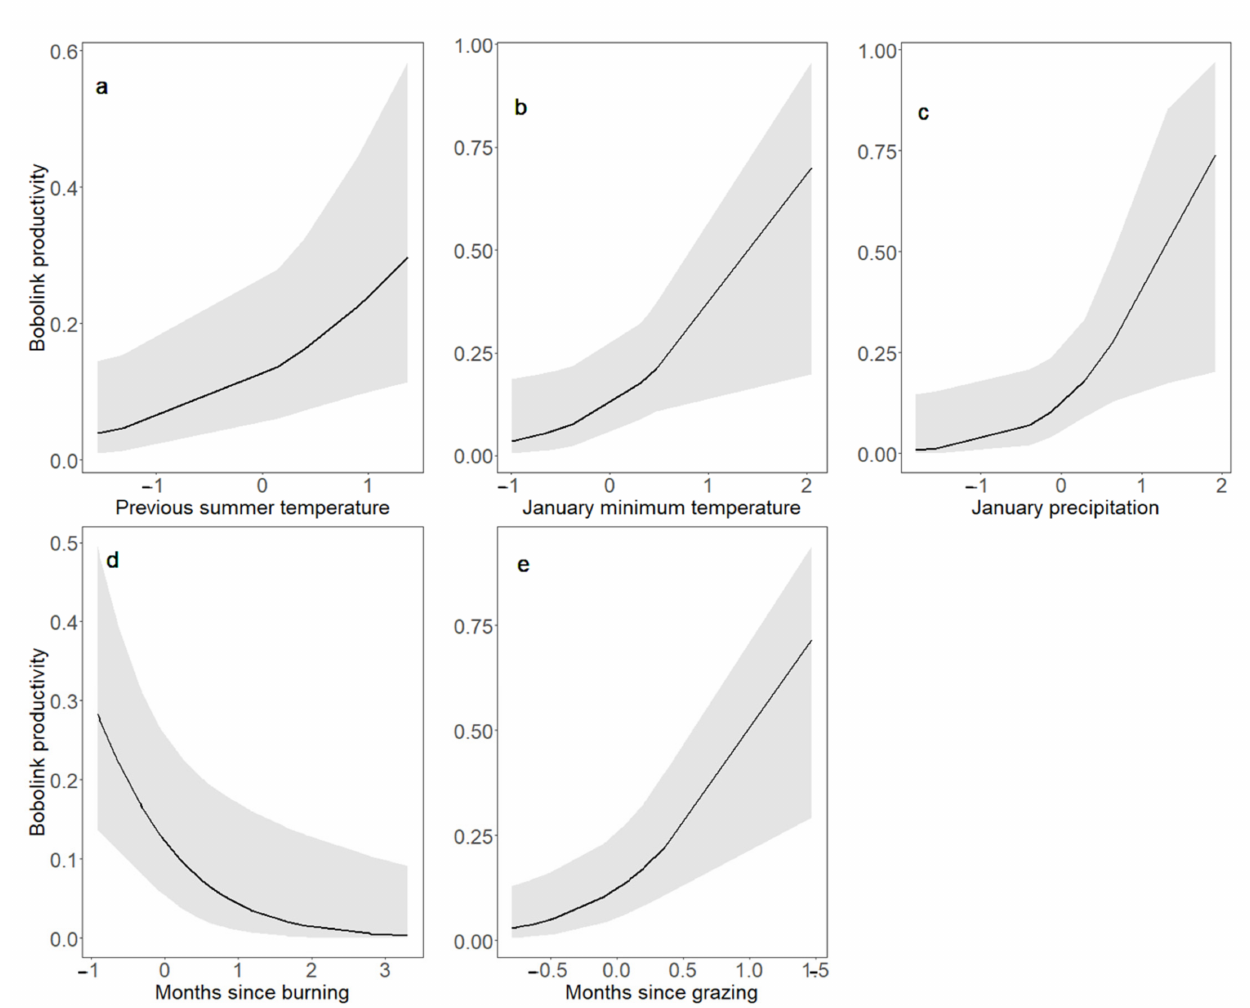
Figure 5. Responses of Bobolink productivity to previous summer temperature ( a ), January temperature ( b ), January precipitation ( c ), months since burning ( d ) and months since grazing ( e ) from 2002 to 2019 in Nebraska, USA. Responses to each predictor were estimated using generalized linear mixed models while keeping the value of other predictors constant at their means (0 for standardized variables). The black line represents the mean, while the shaded area corresponds to the 95% confidence